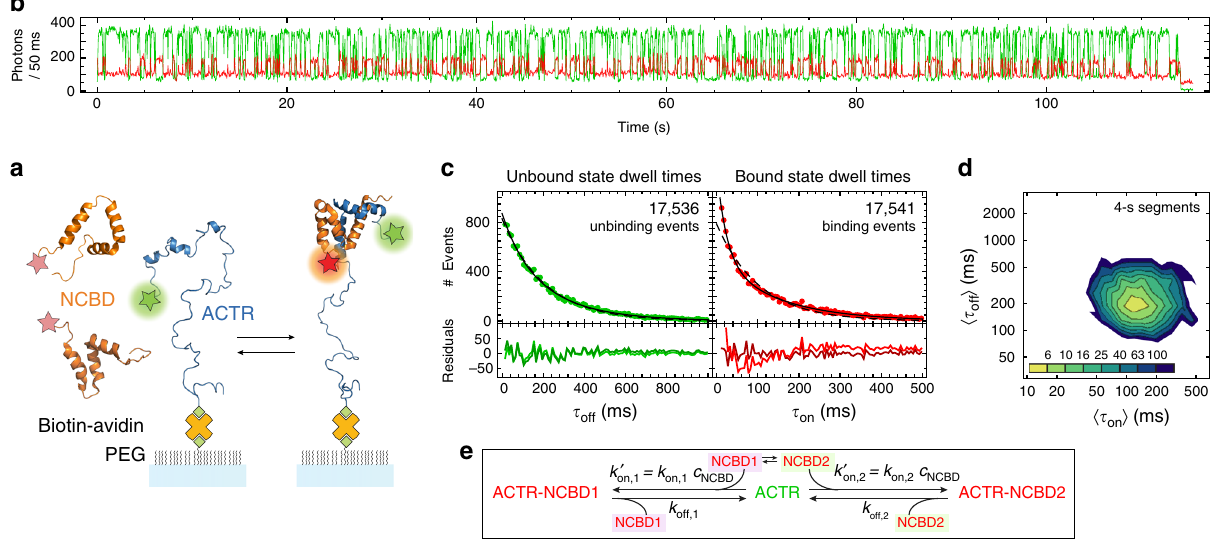
Fig. 2 Binding of NCBD to single surface-immobilized ACTR molecules. a Schematic representation of acceptor-labeled NCBD (orange) binding to surface- immobilized donor-labeled ACTR (blue). b Representative single-molecule time trace (donor emission green, acceptor emission red). c Dwell-time distributions of the unbound state (green) and the bound state (red) with single-exponential (dashed lines, light residuals) and double-exponential fi ts (solid lines, dark residuals). d 2D histogram of 〈 τ on 〉 and 〈 τ off 〉 from 75 time traces, showing a single cluster. e Kinetic model used to analyze the time traces, with two different NCBD states interacting with þ k ′ ¼ k ⋅ c association rate coef fi cients, k ′ ( k ′ NCBD1 on ; 1 on ; 1 on ; 2 on ; 1 ¼ k ⋅ c and k ′ NCBD2 , where k on,1/2 are the second-order rate on ; 2 on ; 2 coef fi cients and c NCBD1/2 the concentrations of NCBD1/2 free in